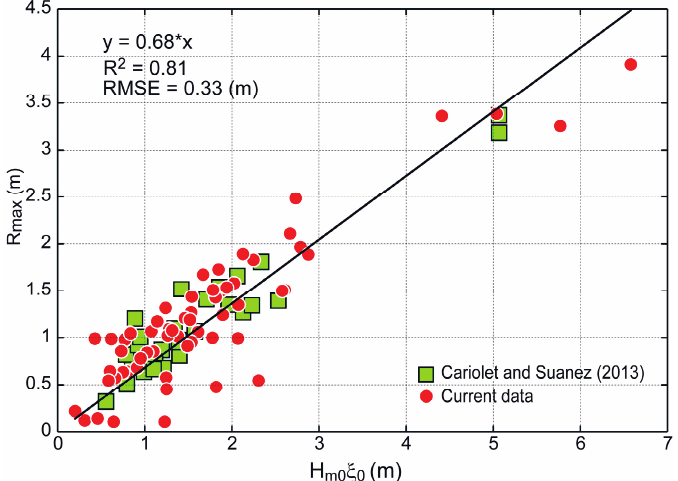
Figure 7. Correlation between observed runup ( R max ) and H m0 ξ 0 . Equation R max = 0.68 H m0 ξ 0 is obtained; it was R max = 0.67 H m0 ξ 0 from Cariolet and Suanez [33] previous